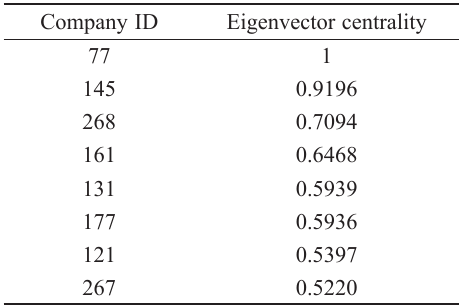
Table 5. The highest eigenvector centrality scores of the general network Company ID